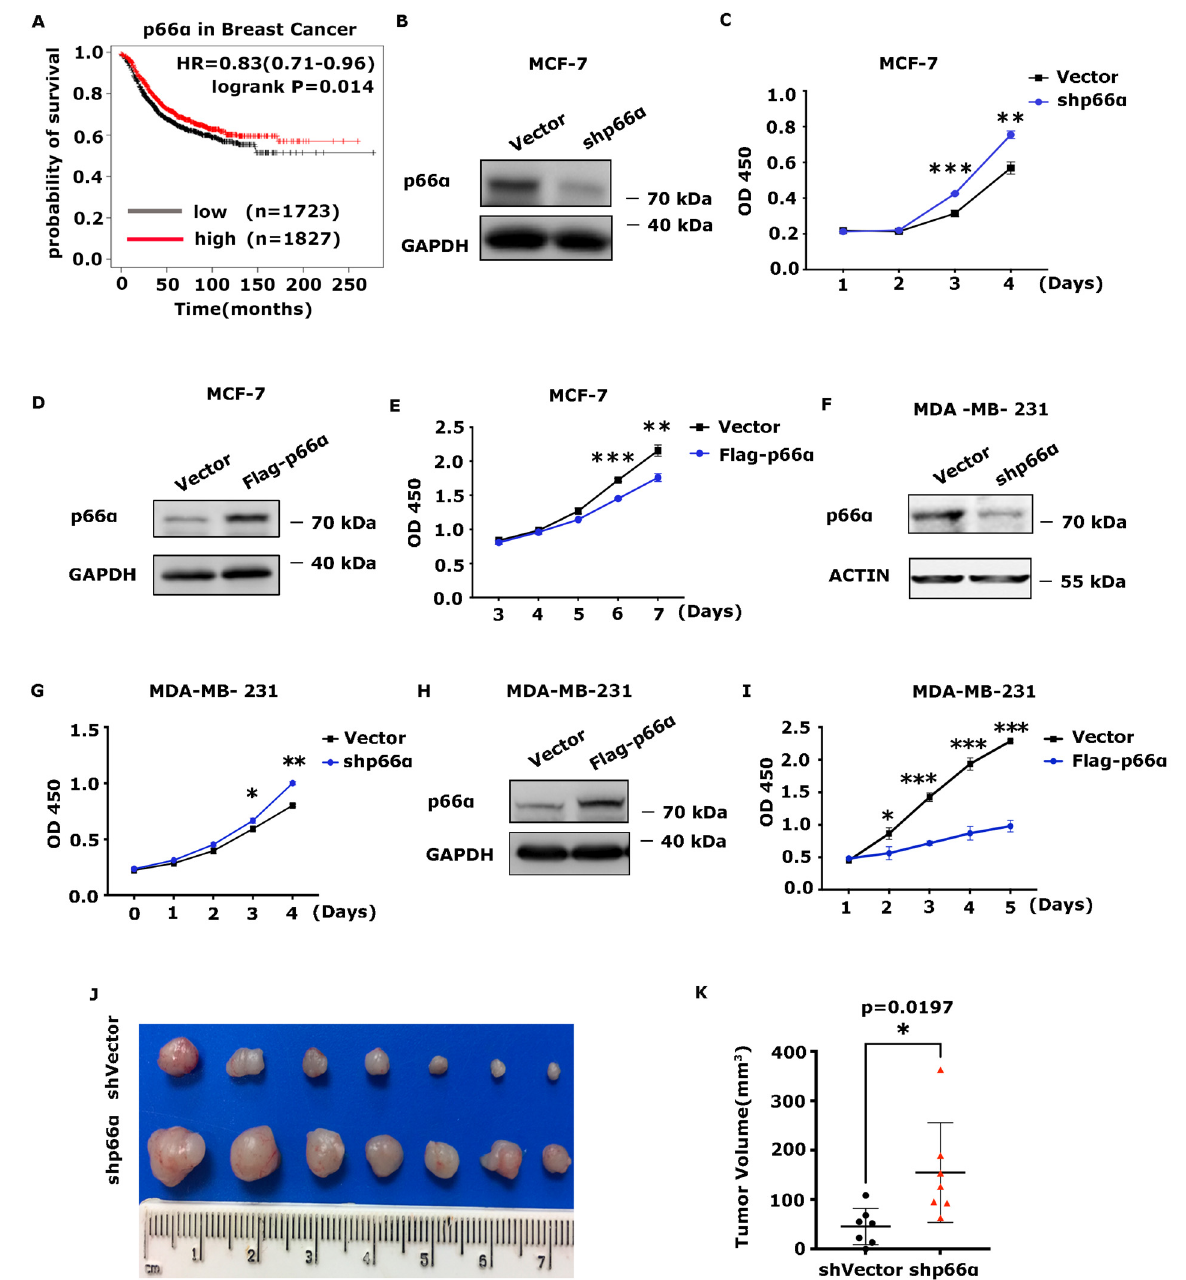
Figure 1. p66 α inhibits breast cancer cell growth. ( A ) Kaplan-Meier plot of the relapse-free survival of patients with breast cancer stratified by p66 α . ( B ) Western blot assays showed that p66 α was effectively depleted in the MCF-7 cell line. ( C ) Cell growth curves of p66 α knockdown MCF-7 cells and control cells. ( D ) Western blot assays showed that p66 α was over-expressed in the MCF-7 cells. ( E ) Cell growth curves of MCF-7 cells overexpressing p66 α or mock vector. ( F ) Western blot assays showed the depletion of p66 α in the MDA-MB-231 cells. ( G ) The cell growth curves of p66 α